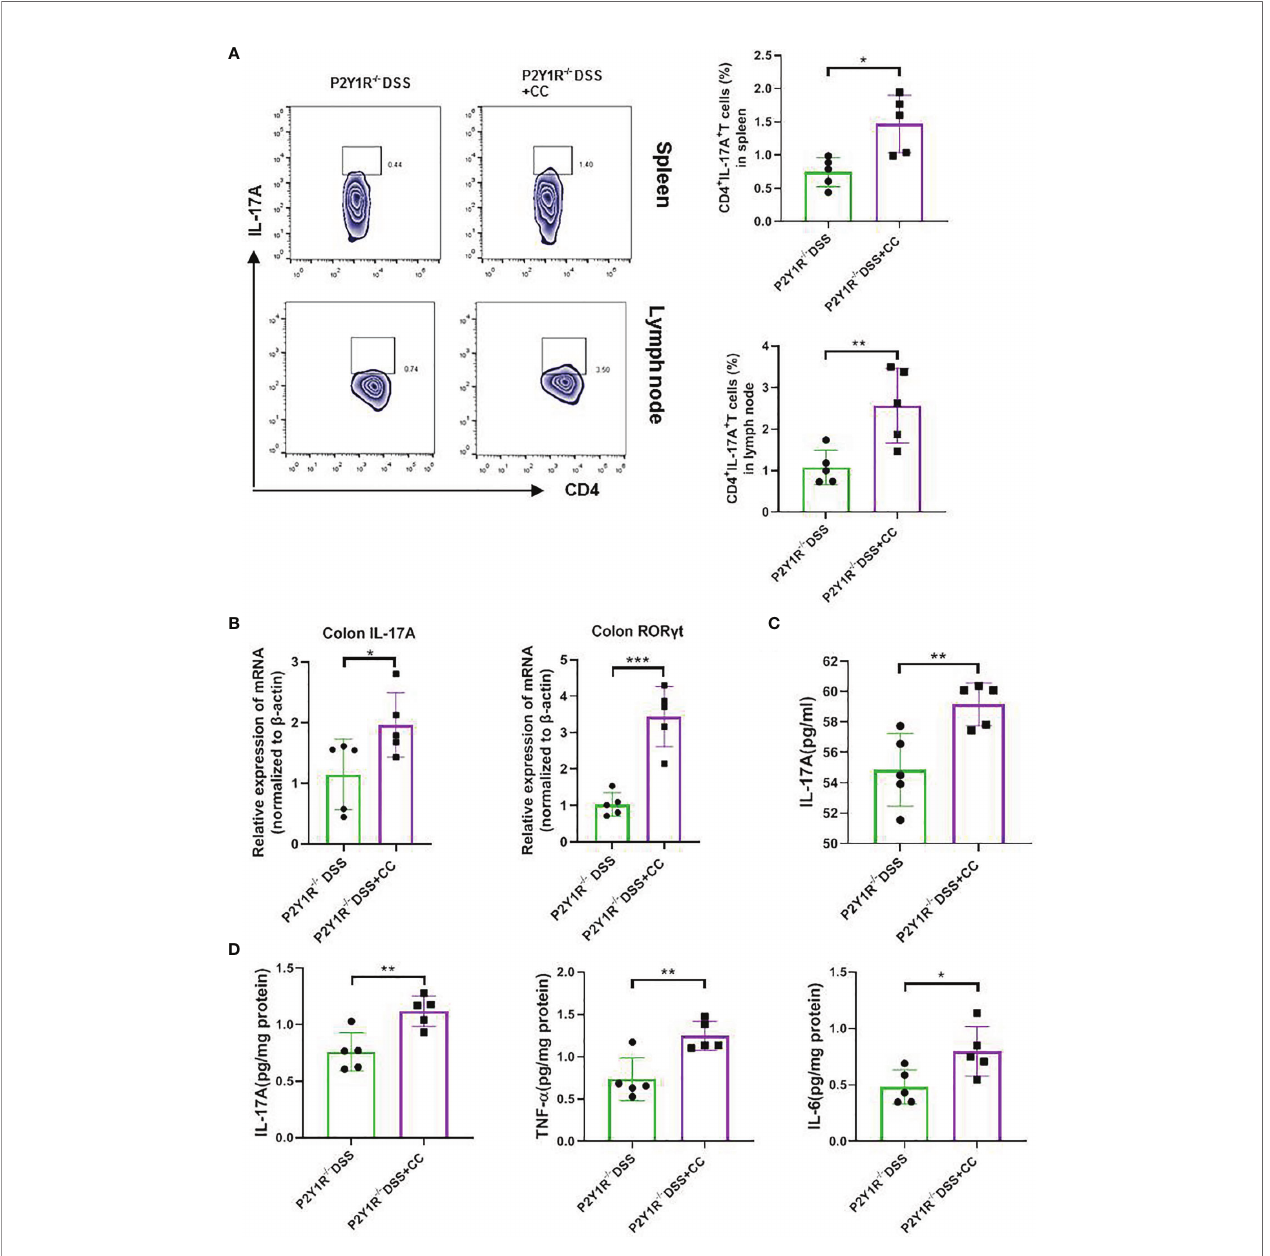
FIGURE 6 | Blockage of AMPK increased the Th17 responses of DSS-treated P2Y1R -/- mice. (A) The frequency of Th17 cells in the spleen and mesenteric lymph nodes (MLN) of DSS-treated P2Y1R -/- mice. (B) mRNA expression of IL-17A and ROR g t in the colon of DSS-treated P2Y1R -/- mice. (C) Levels of proin fl ammatory cytokines IL-17A in the serum of DSS-treated P2Y1R -/- mice. (D) Levels of proin fl ammatory cytokines IL-6, IL-17A and TNF- a in the colon tissues of DSS-treated P2Y1R -/- mice. Data are expressed as mean ± SEM (n=5). *p < 0.05, **p < 0.01 and ***p <